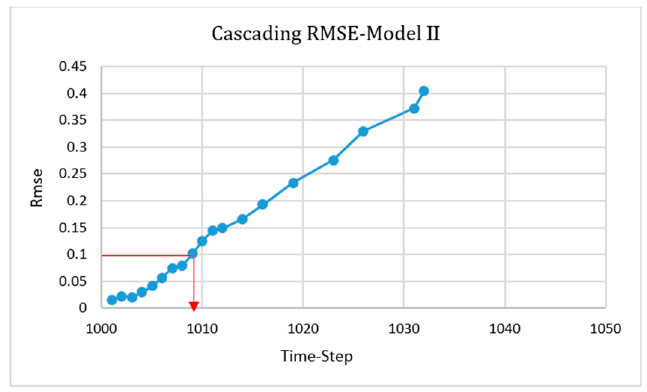
Figure 26. Root mean square equation (RMSE) of the cascading condition for Model II.